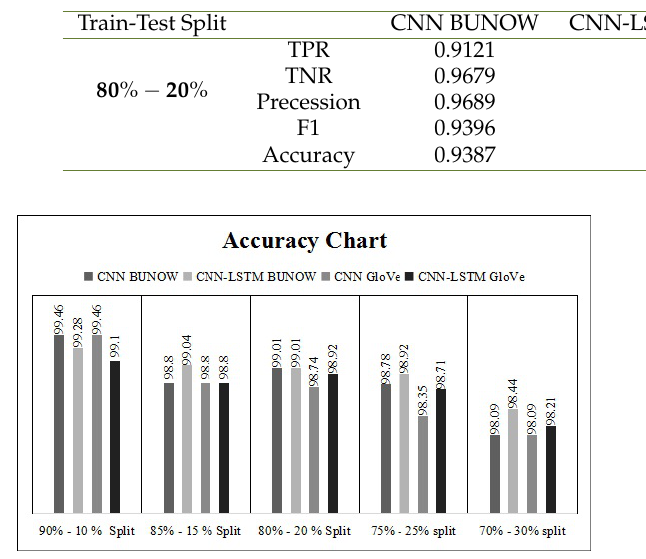
Fig. 6. Best Accuracies achieved by four models.